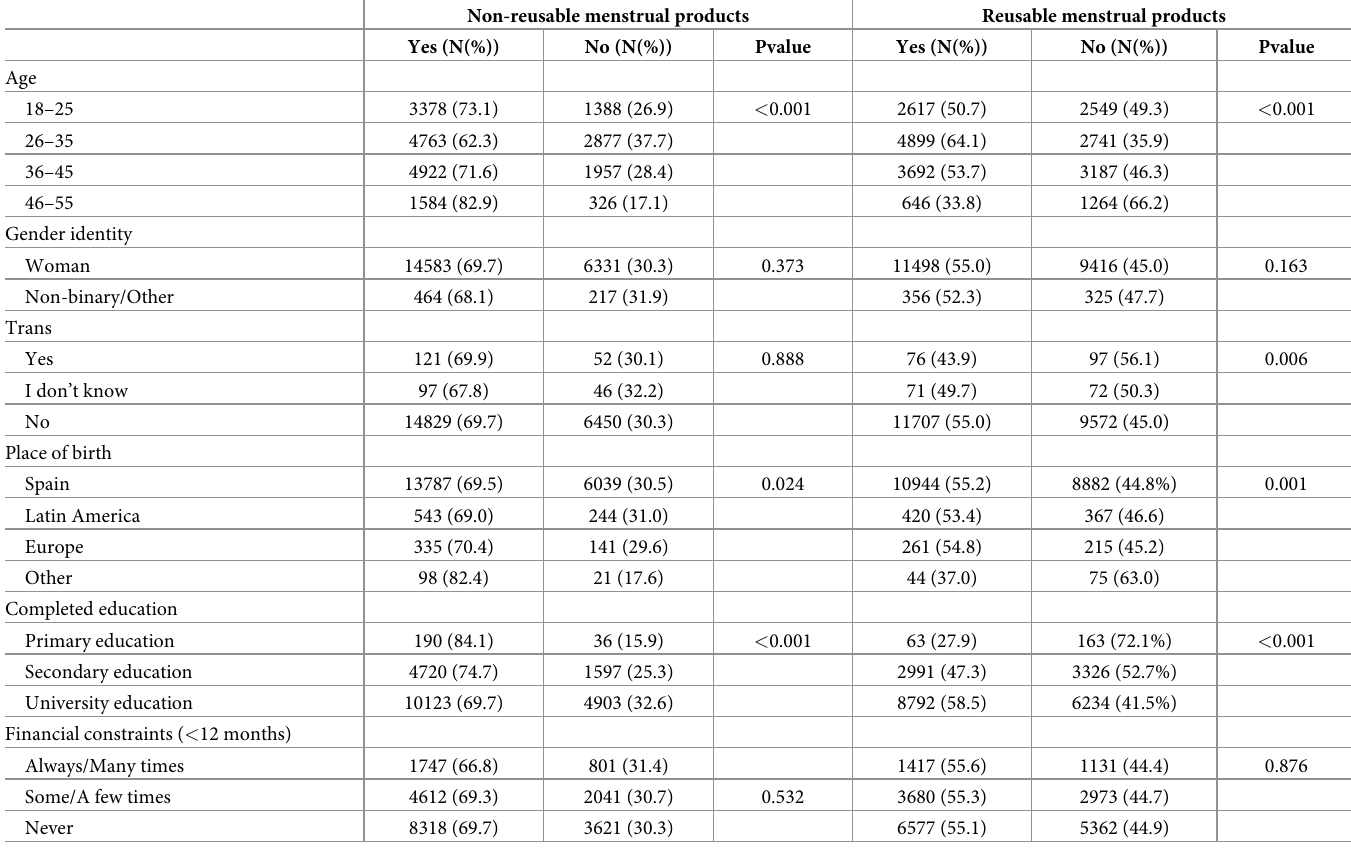
Table 3. Use of non-reusable and reusable menstrual products by age, gender identity, trans identification, country of birth, completed education and financial con- straints (last 12 months) (N = 22,823). Non-reusable menstrual